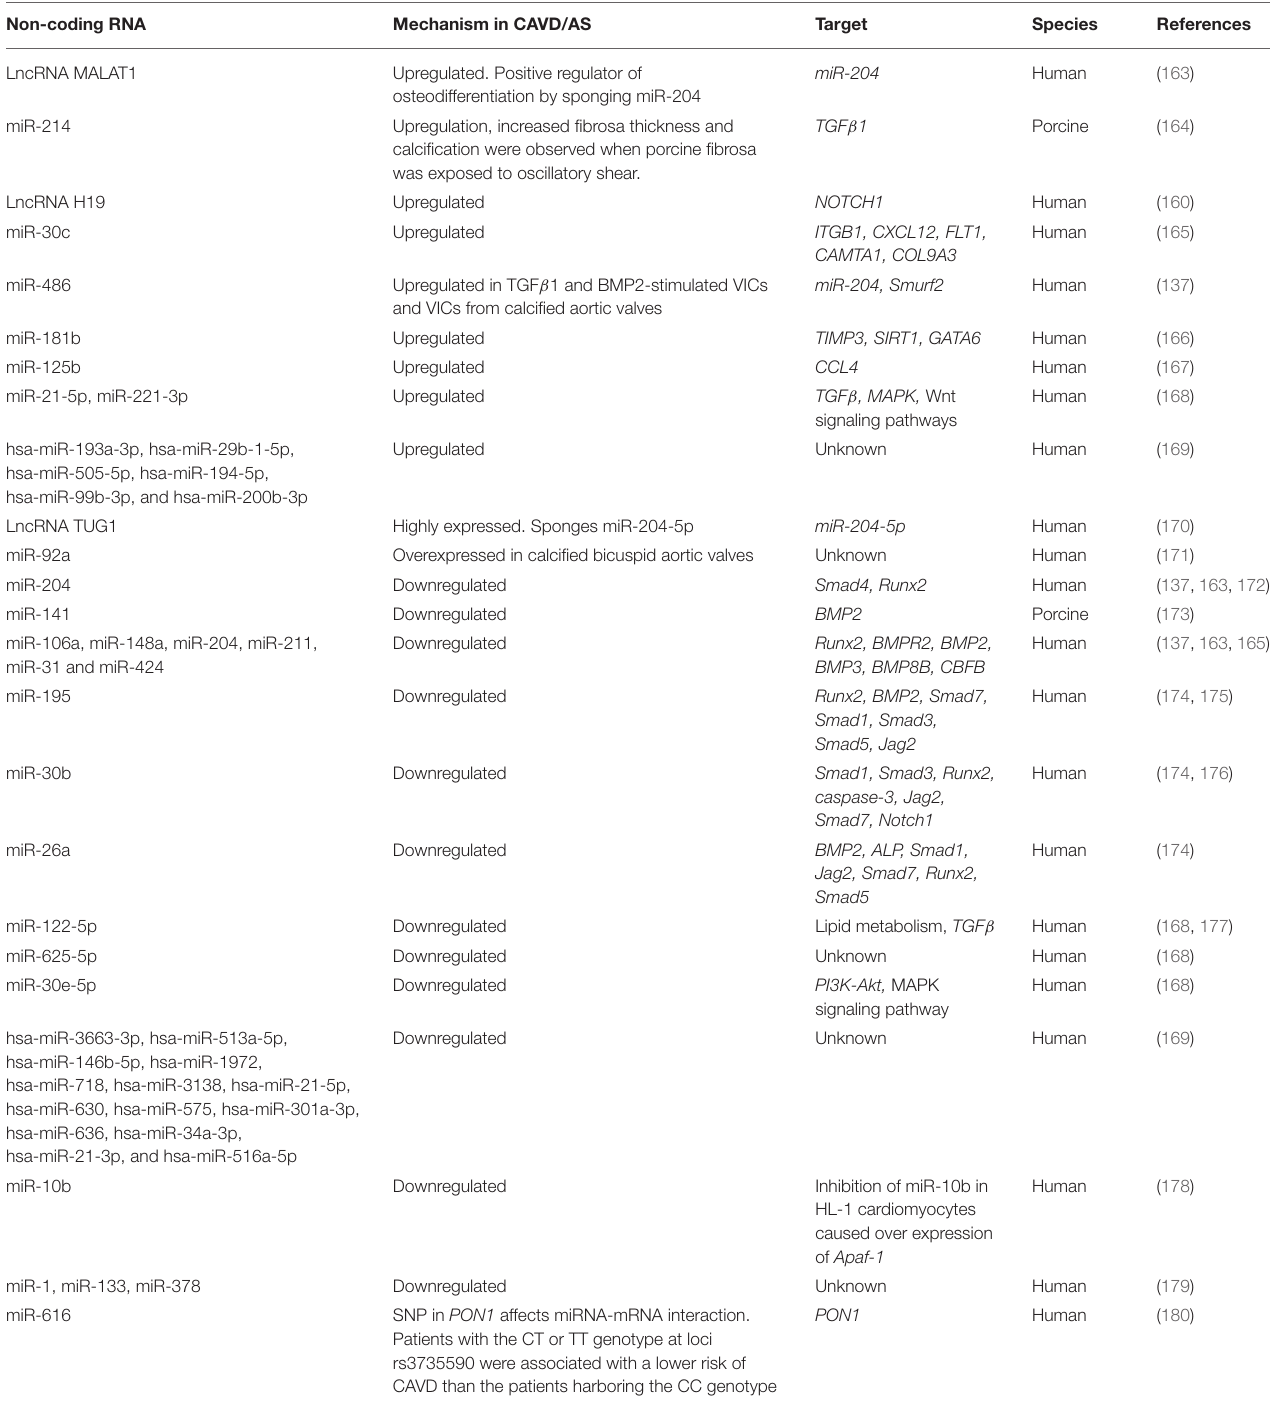
TABLE 2 | Role of non-coding RNAs in CAVD/Aortic Stenosis. Non-coding